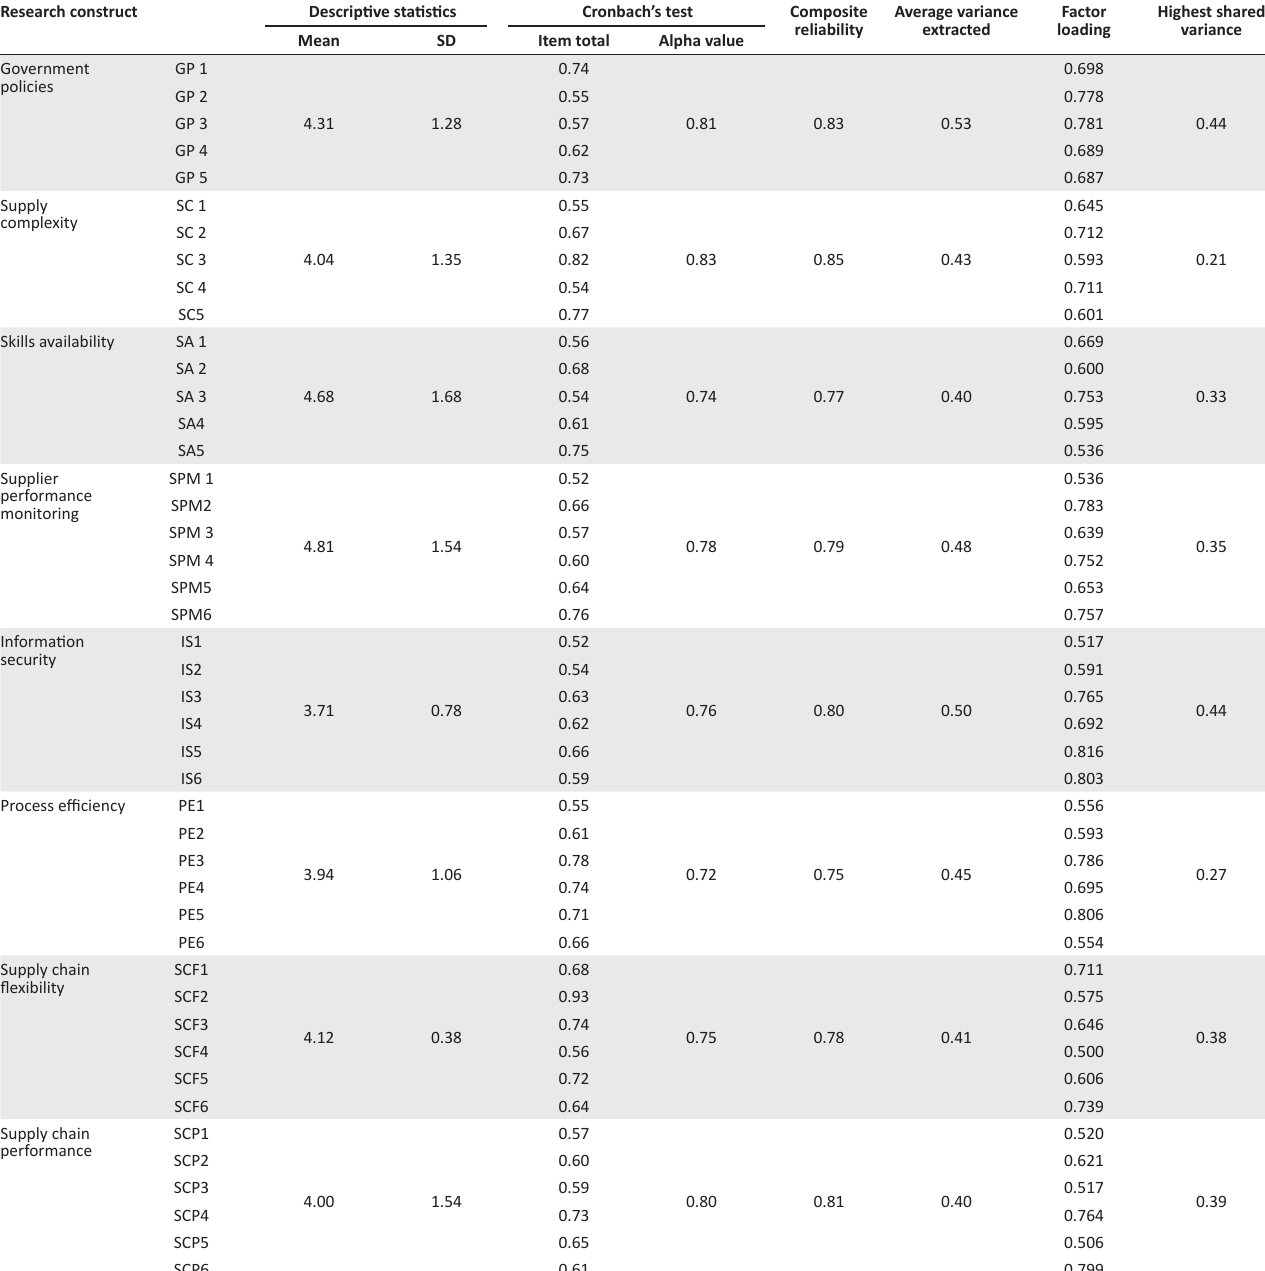
TABLE 2: Accuracy analysis